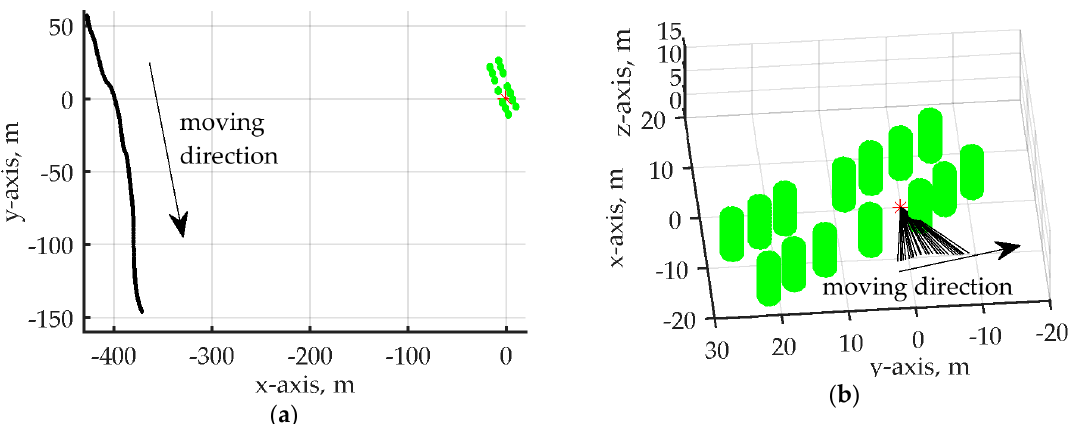
Figure 9. The selected measurement scenario represented by cylindrical tree canopies: ( a ) Tx positions (black line) and tree canopies (green cylinders); ( b ) detail of the alley with Rx marked by the red asterisk, tree canopies represented by the green cylinders and Tx–Rx directions shown by the black lines. The Cartesian coordinate system is aligned so that the origin is at the Rx position, the x , y , and z axes point towards the east, north and zenith, respectively. Tx moving direction is denoted by the arrow.